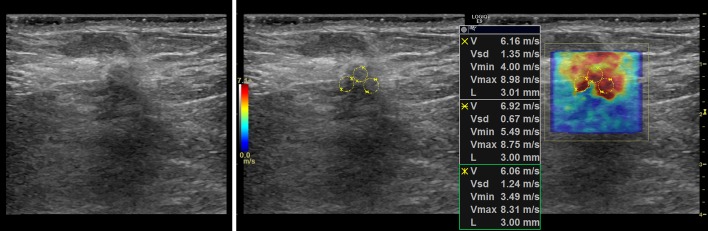
Shear wave map of a 1.05cm malignant breast diagnosed as invasive ductal carcinoma grade I.The average elasticity was Emean = 120.3 kPa.